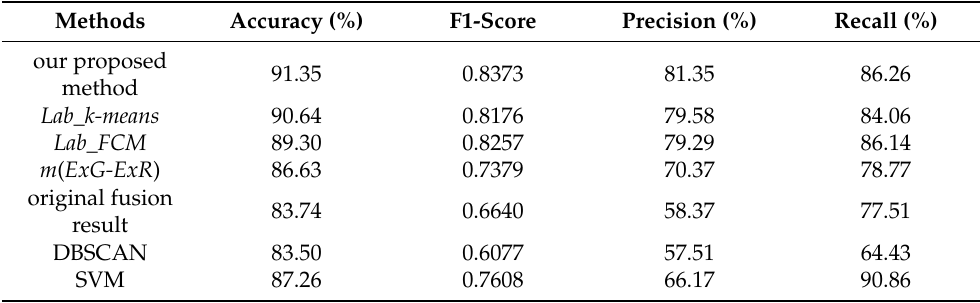
Table 3. The average accuracy of different results extracted by different methods from the three